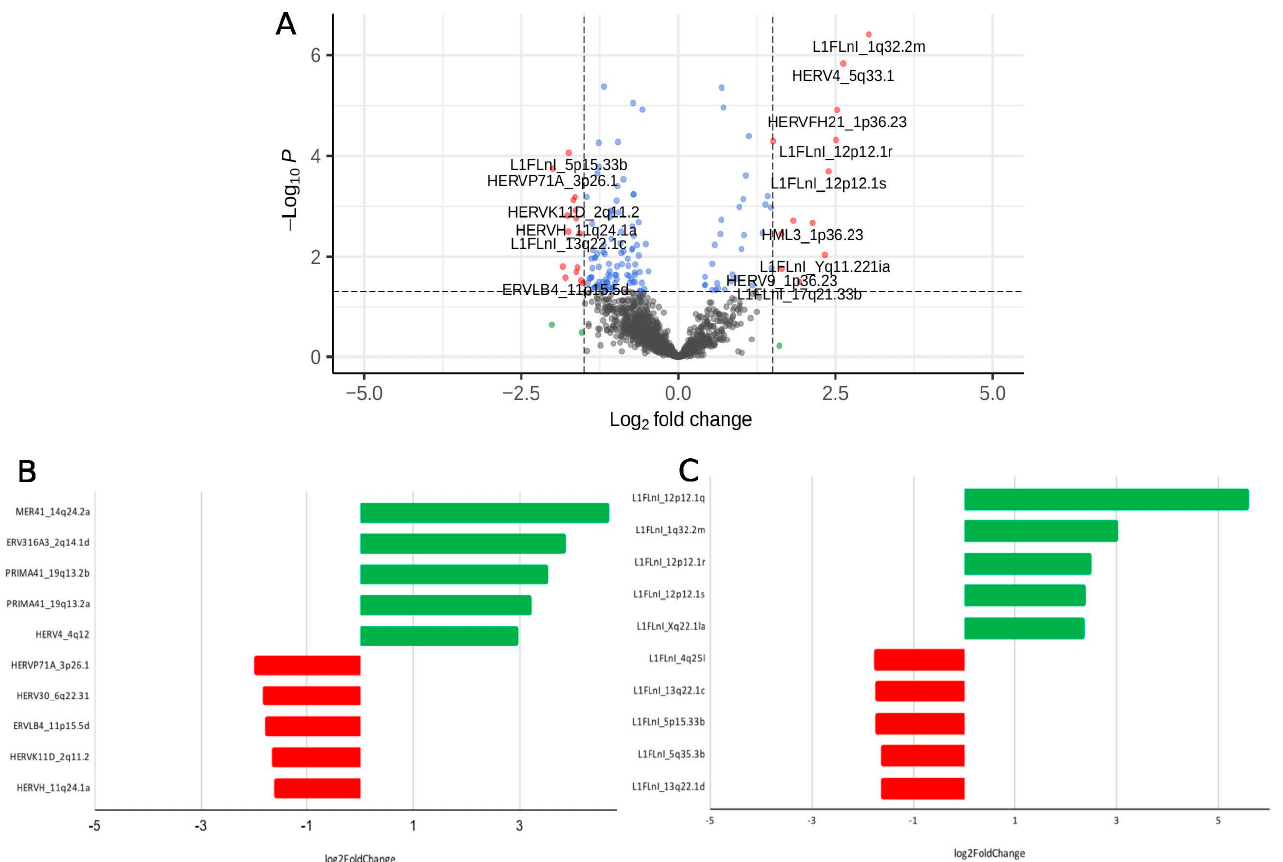
Figure 1. Differential expression of transposable elements in CD4 T cells treated with Ingenol B. ( A ) Volcano Plot of the comparison Ingenol B vs. DMSO; Top differentially expressed HERV ( B ) and ( C ) LINE-1 loci.